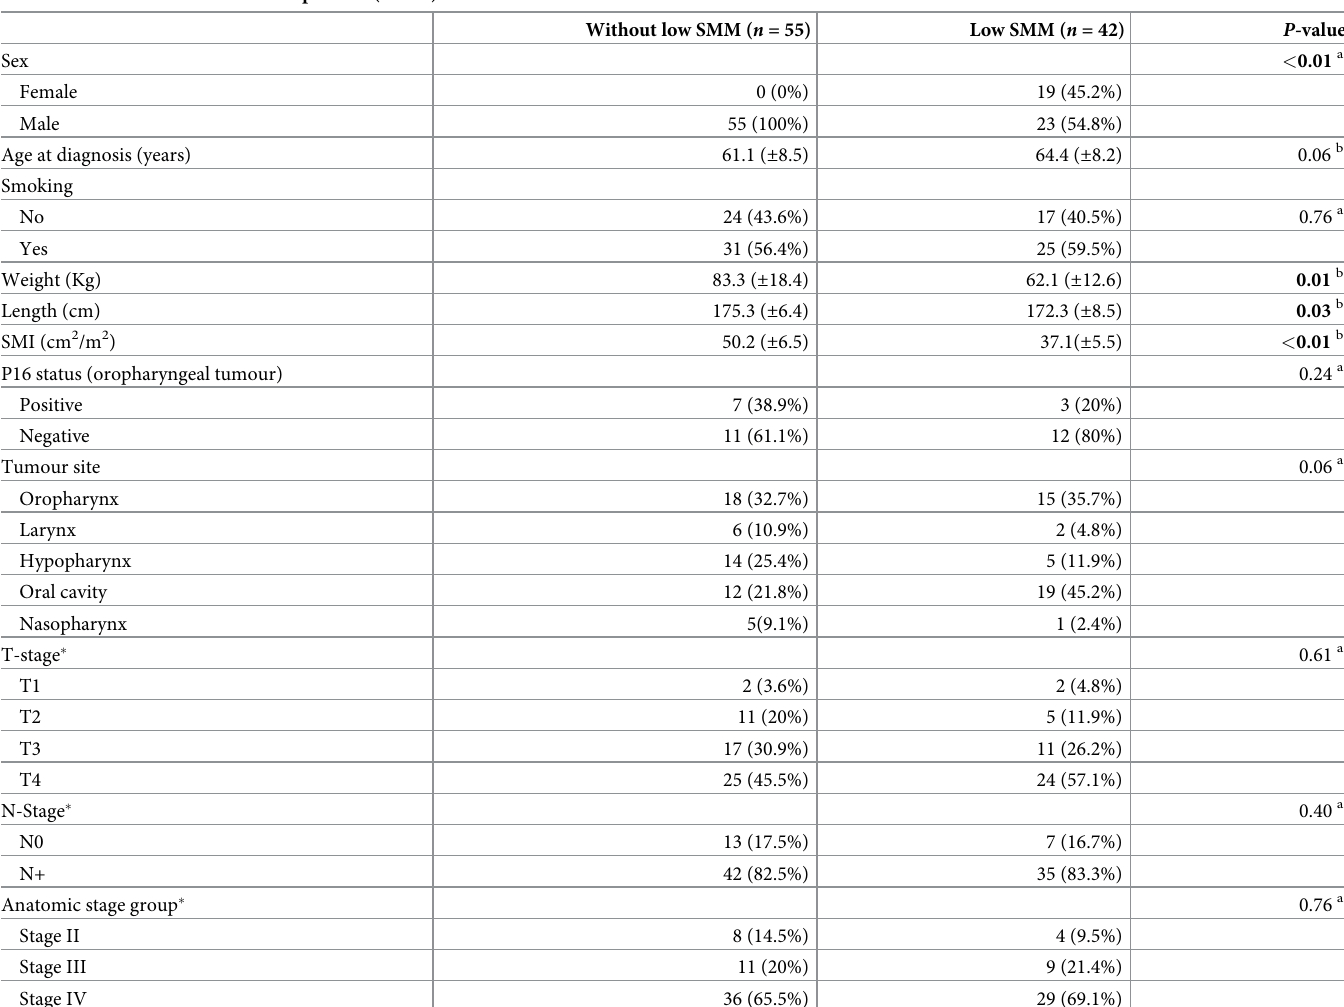
Table 1. Characteristics of included patients (n =